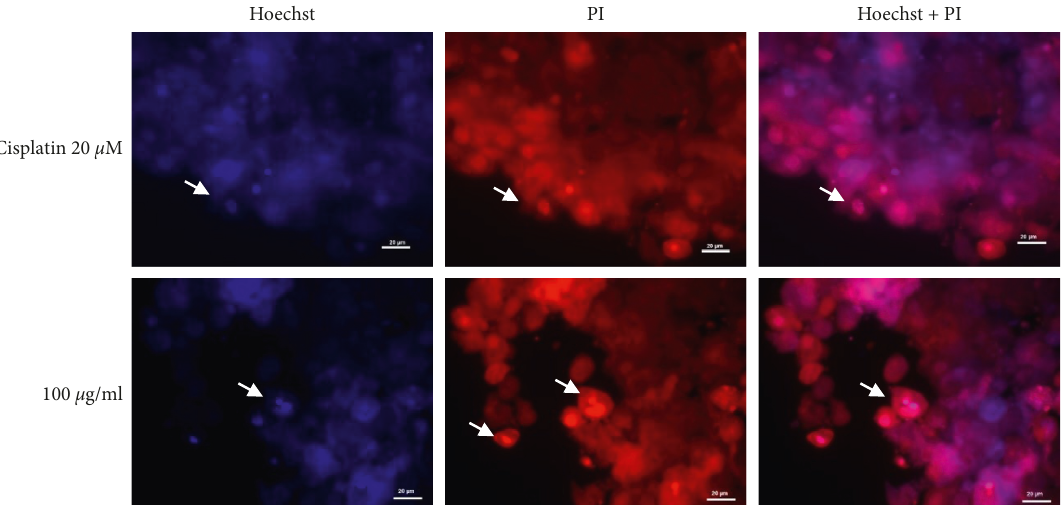
Figure 6: Hoechst and PI double staining for CAL27 spheroids (ROI). A close-up of the most representative images of the proapoptotic effect of 100 μ g/ml of PME and 20 μ M cisplatin at 72hours is shown. Some apoptotic bodies (arrows ⟶ white) are observed in the treated spheroid proliferative